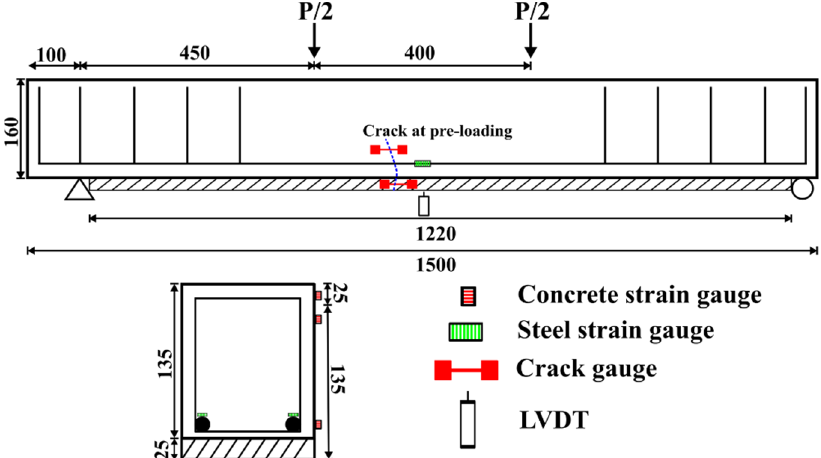
Figure 1. Schematic of specimen and test setup.